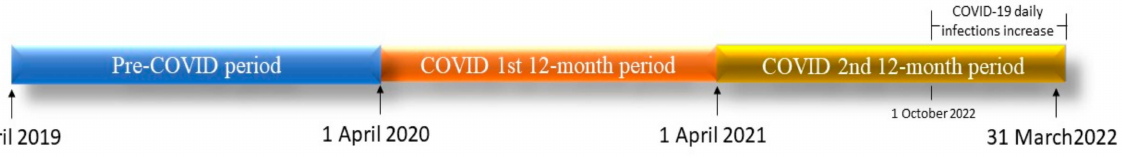
Figure 2. Explanatory timeline of the periods used for the study.